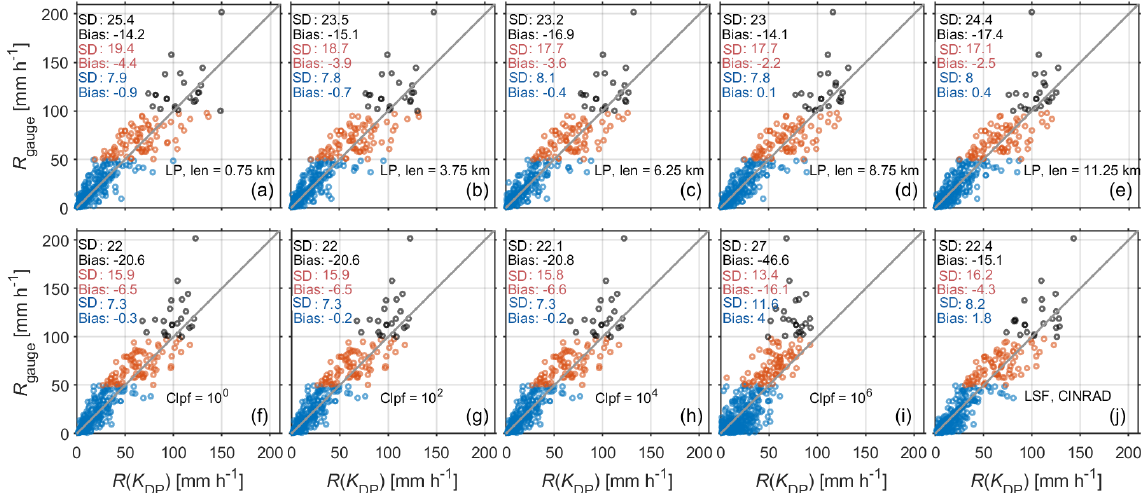
Figure 7. K DP -based hourly rainfall accumulation vs. gauge observations from 14:00 to 17:00LST. K DP was estimated using the (a– e) LP, (f–i) Maesaka, and (j) LSF methods. Rain rates were divided into three groups: R gauge < 50mmh − 1 (blue), 50mmh − 1 ≤ R gauge < 100mmh − 1 (red), and 100mmh − 1 ≤ R gauge (black). The standard deviation (SD) and bias between R gauge and R(K DP ) for each group are marked using the corresponding colors. R = 51 K 0 . 86 was DP